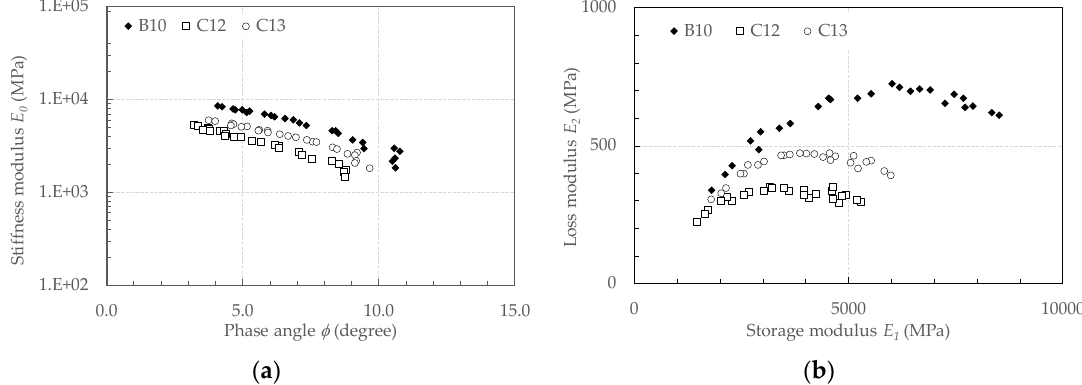
Figure 13. Measured values of E 0 for CRAM: ( a ) Black diagram; ( b ) Cole–Cole diagram